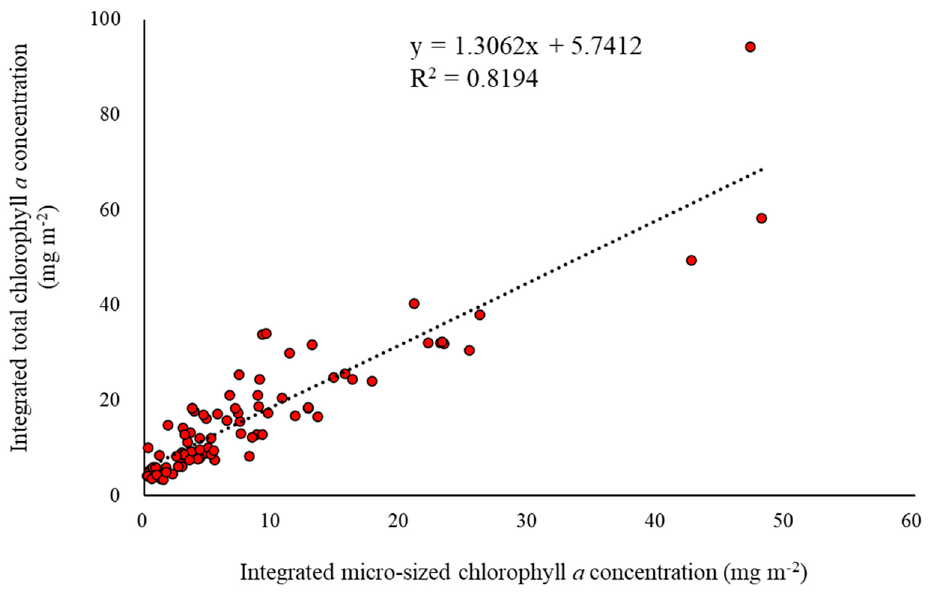
Figure 4. Relationship between the euphotic depth-integrated micro-sized chlorophyll a concentrations and the integrated total chlorophyll a concentrations in Jaran Bay.